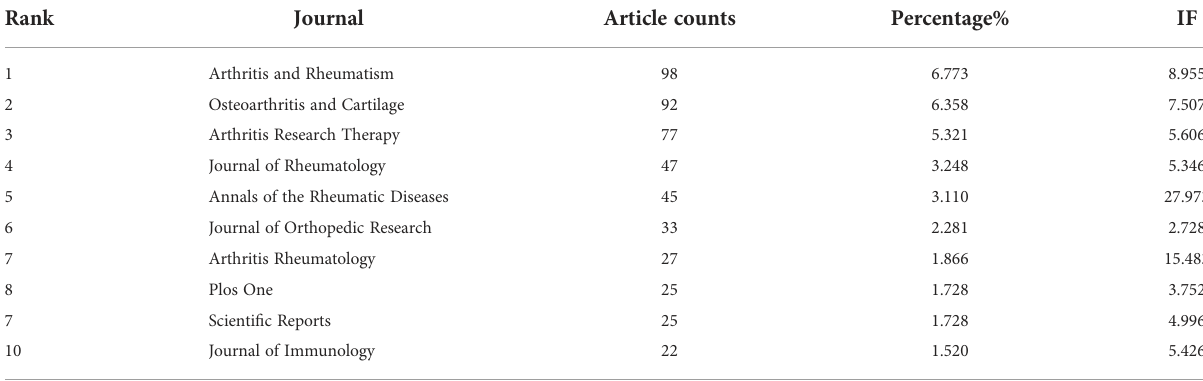
TABLE 2 The top 10 productive journals related to macrophages associated with